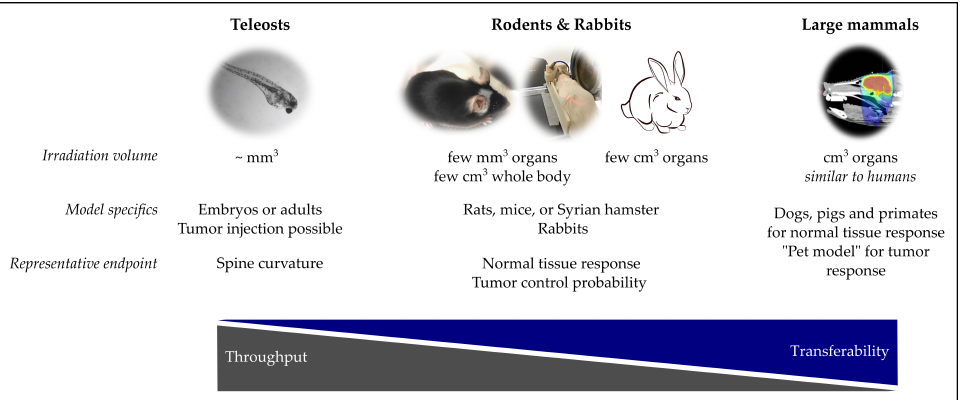
Figure 3. Overview of in vivo models for proton radiobiology experiments. Images (left to right): Irradiated zebrafish embryo [68], C57BL/6 mouse after proton brain irradiation [59], rat proton irradiation setup at Institut Curie [32], rabbit photon treatment plan of a mini-pig brain